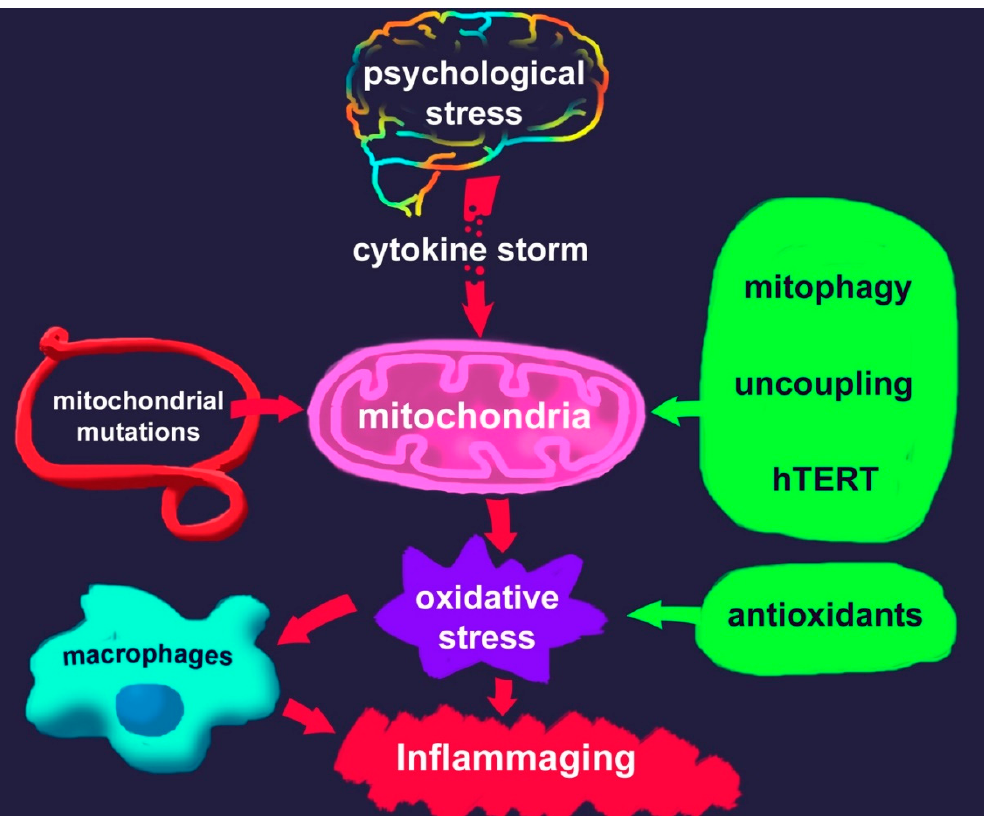
Figure 1. Scheme of the association between psychological stress and inflammaging through oxidative stress; potential interventions to reduce the resulting detrimental effects are listed on the right.